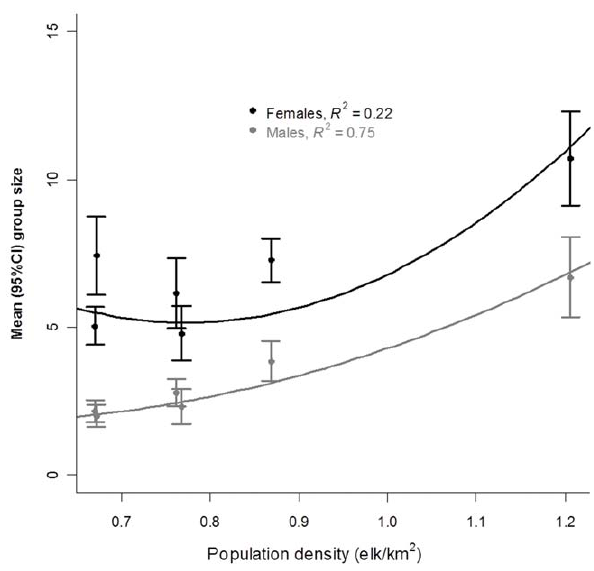
Figure 1. Relation between mean group size and population density for female ( black ) and male ( gray ) elk in Riding Mountain National Park ( 2002–2005 and 2007–2009 ) . Lines are quadratic fits to the mean group size data illustrating: (a) density- dependent change in females, including negative density-dependence at low density; and (b) weak density dependence for